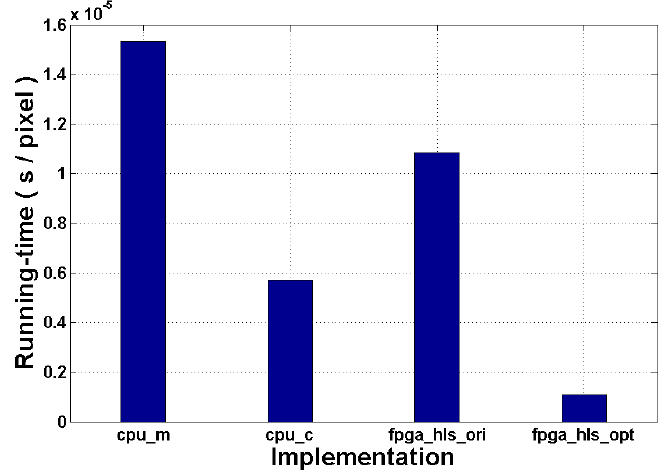
Figure 11. Running time